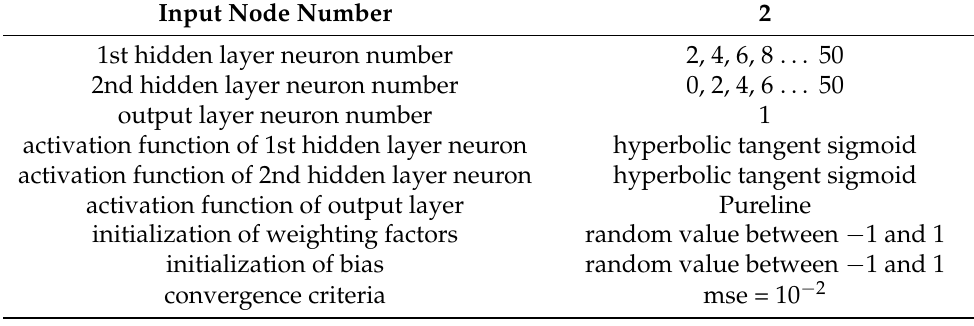
Table 4. Parameters for building the BPNN.